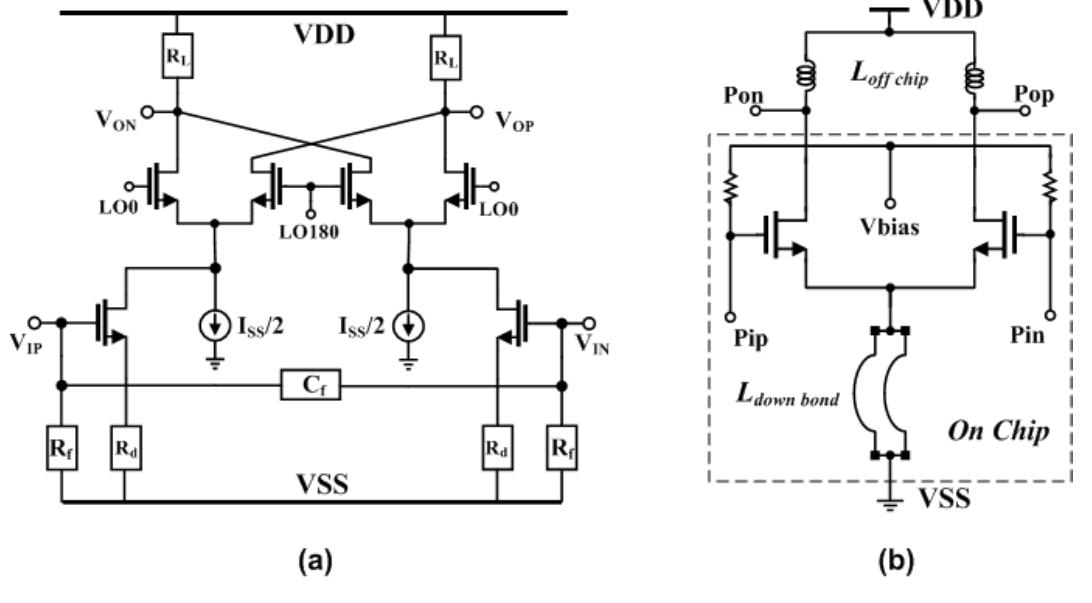
Figure 4. Transmitter circuits. ( a ) Up-conversion I/Q-modulator using current-mixing scheme. ( b ) Drive-amplifier with off-chip